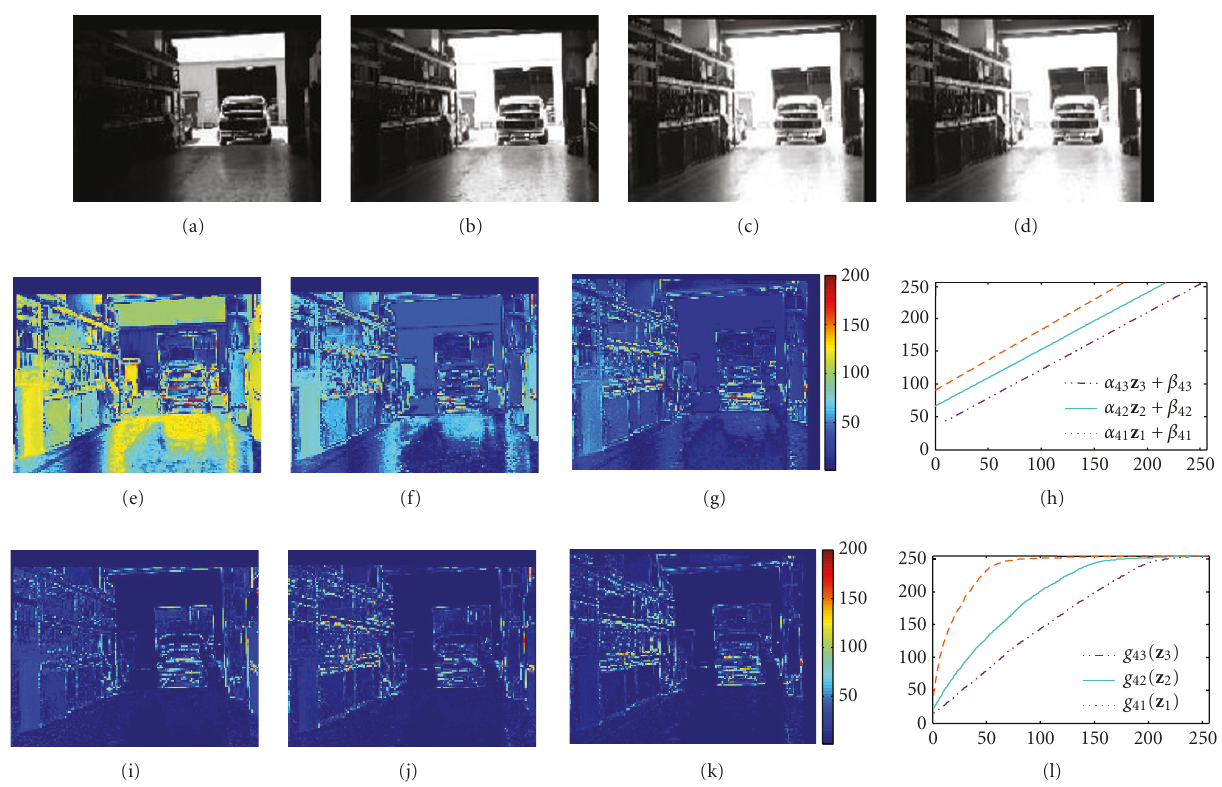
Figure 1: Comparison of a ffi ne and nonlinear photometric conversions. (a)–(d) are the images captured with di ff erent exposure rates. All camera parameters other than the exposure rates are fixed. The images are geometrically registered. The relative exposure rates are as follows: (a) image z 1 with exposure rate 1 / 16; (b) image z 2 with exposure rate 1 / 4; (c) image z 3 with exposure rate 1 / 2; (d) image z 4 with exposure rate 1. Image z 4 is set as the reference image and other images are photometrically registered to it. The residuals and the registration parameters are shown; (e) residual between z 4 and photometrically aligned z 1 using the a ffi ne model; (f) residual between z 4 and photometrically aligned z 2 using the a ffi ne model; (g) residual between z 4 and photometrically aligned z 3 using the a ffi ne model; (h) the photometric mappings for (e)–(g); (i) residual between z 4 and photometrically aligned z 1 using the nonlinear model; (j) residual between z 4 and photometrically aligned z 2 using the nonlinear model; (k) residual between z 4 and photometrically aligned z 3 using the nonlinear model; (l) the photometric mappings for